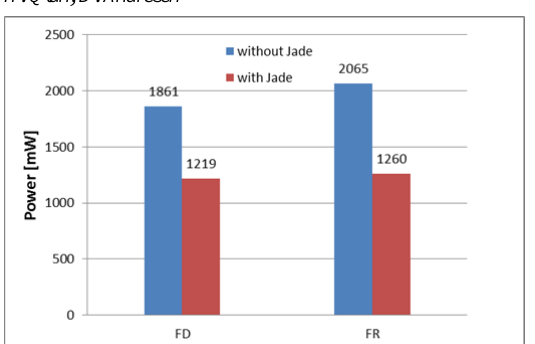
Figure 10: Average power consumption of FaceDetection and FindRoute